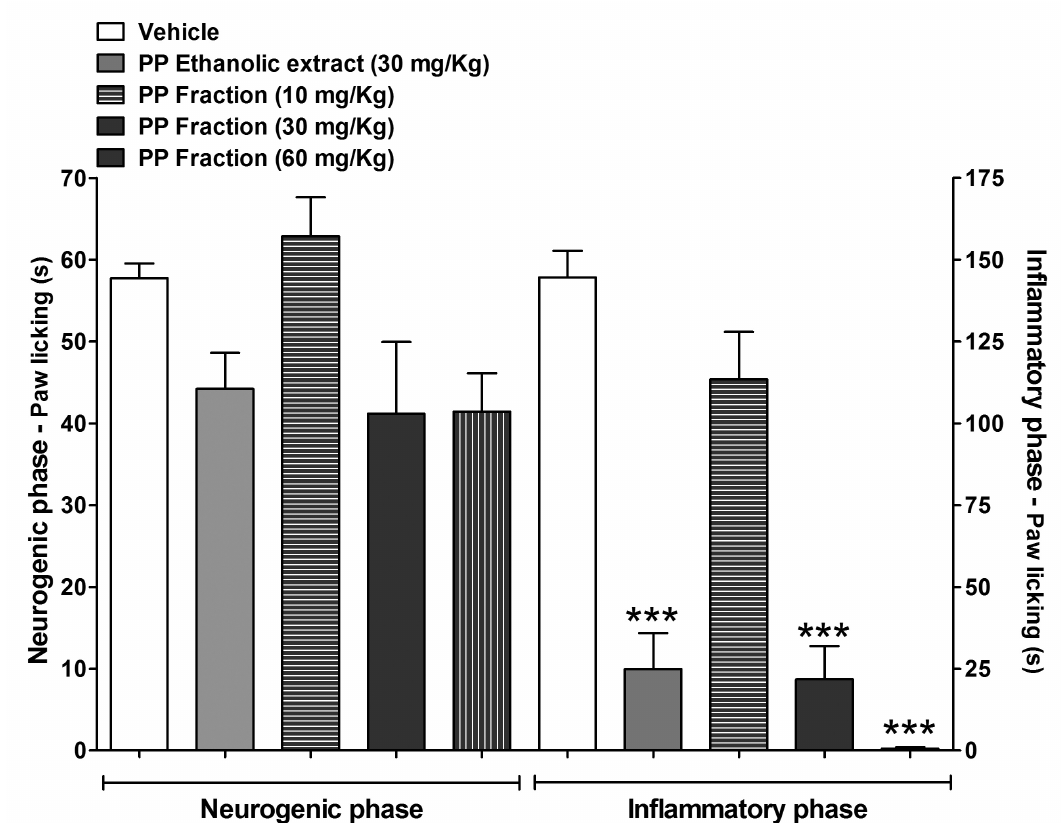
Figure 2 - Effect of PPAC fraction (10, 30 and 60 mg/kg) and EE (30 mg/kg) on formalin-induced pain in mice after i.p. administration. Each column represents the mean ± SEM. of 6–11 animals. ***p<0.001 in a one-way ANOVA Bonferroni